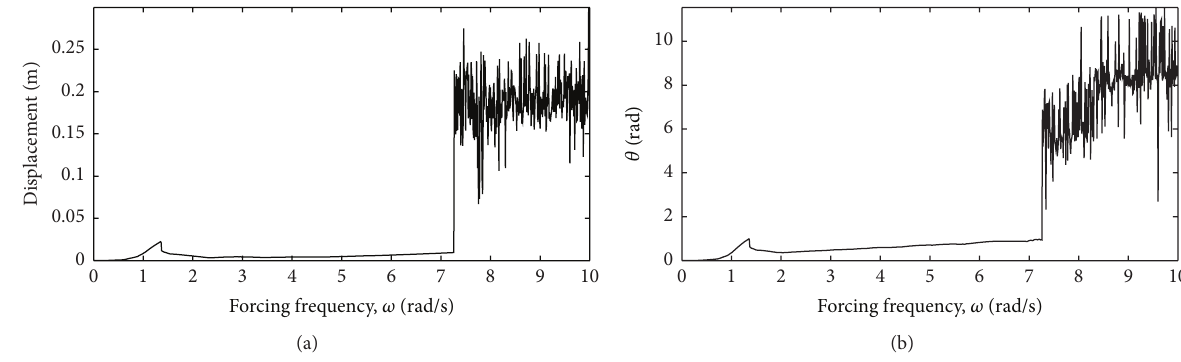
Figure 8: Frequency response curves for Ω min = 15850 rpm: tip response of beam (a); gyro response (b) for 𝑘 = 𝐼 𝑜 𝜔 2 𝑛 /2 = 6.4 Nm / rad and = 𝐼 𝜔 2 /4𝜔 = 0.9 Nms / rad with the base excitation of 𝑧 = 0.05 cos (𝜔𝑡) . 𝑐 opt 𝑜 𝑔 𝑛